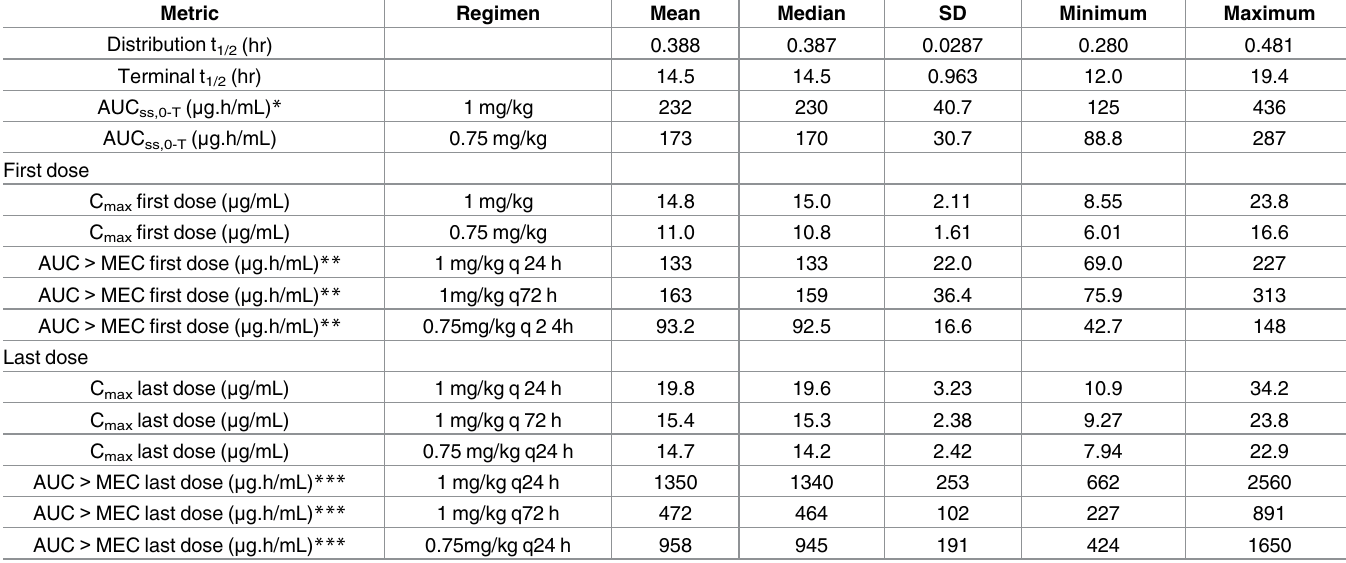
Table 2. Summaryof caspofungin model-independent pharmacokinetic parameters and exposure indices from simulations which result in the maximum % animals 10 < C max /MEC < 20 ratio for three dosing regimens administered as 1 h duration infusions (0.75 mg/kg q 24 h, 1 mg/kg q 24 h and 1 mg/kg q72